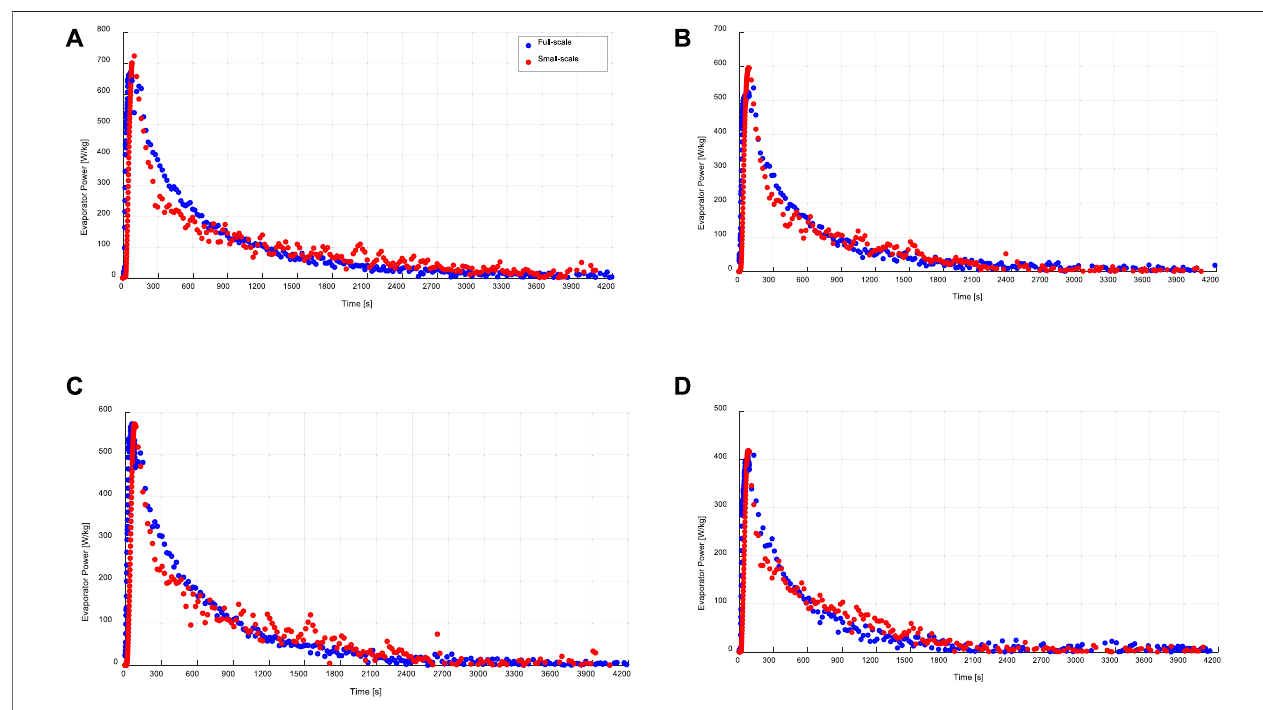
FIGURE 7 | Instantaneous speci fi c evaporation power of the evaporator/condenser unit (full-scale) and that estimated from the kinetic results of the adsorbent sample (small-scale), at a) 15/30/90 ° C, b) 15/35/90 ° C, c) 10/30/90 ° C, d)10/35/90 ° C.